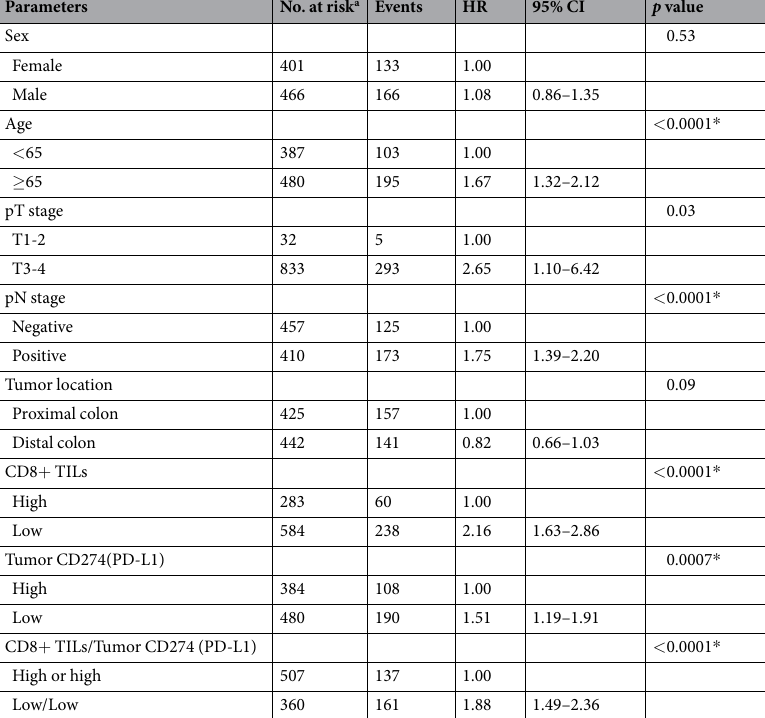
Table 4. Univariate analysis of DFS and known prognostic factors in stage II-III colon carcinoma patients. a Number of cases may differ due to missing data. * p < 0.005 is significant and 0.005 < p < 0.05 is suggestive